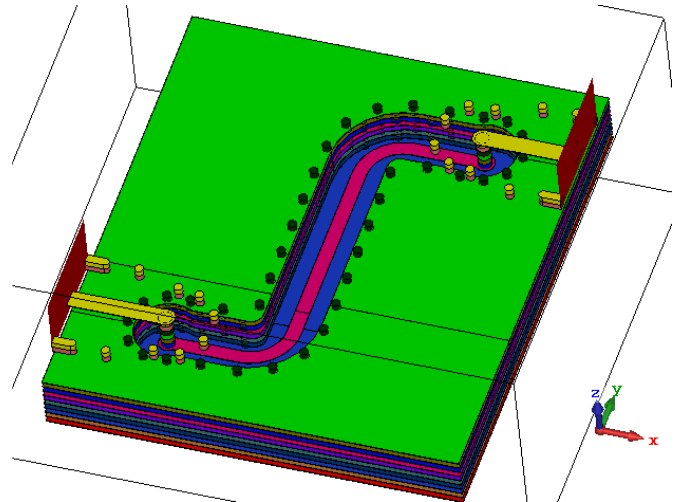
Figure 6. Exploded view of the 3D model used for the transition design.